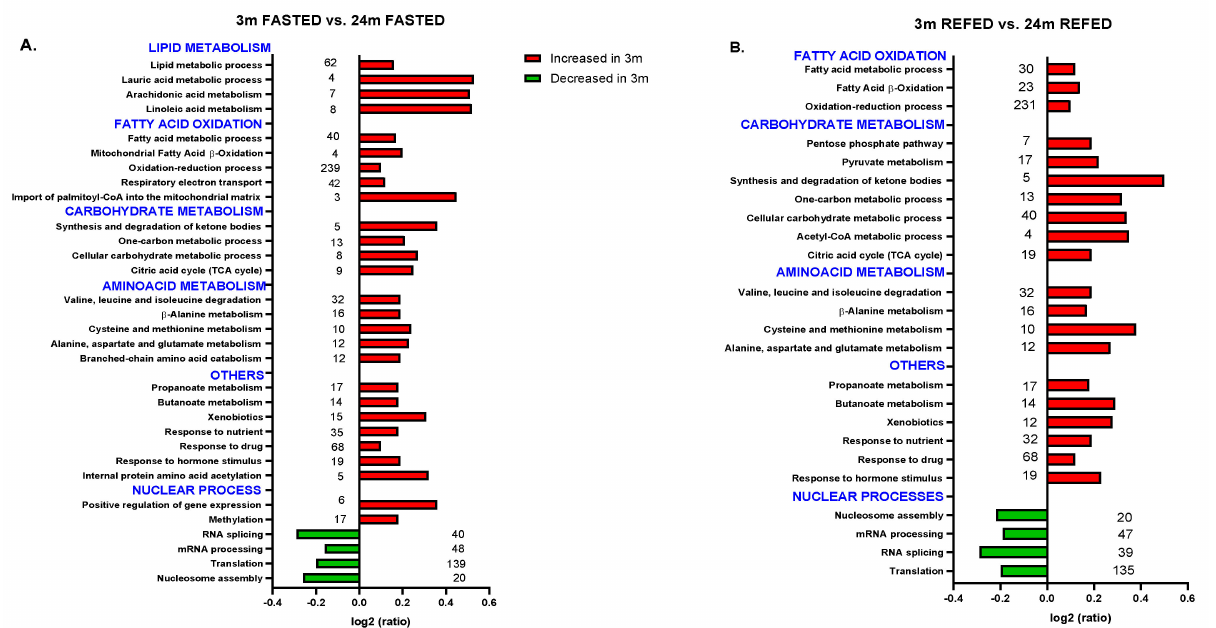
Figure 2. Biological processes and metabolic pathways affected in hepatic NEF of fasted or fasted/refeed rats with aging. Data showed changes in 3- compared with 24-month-old animals. ( A ) Changes after 36 h fasting. ( B ) Changes after 36 h fasting and then refeeding for 30 min. The most representative GOBP and KEGG categories are shown indicating the number of identified proteins per categories. Data are presented as protein log2-ratios between the different experimental groups according to their estimated variances (z q values, see Supplementary Table S4). Red colors represent processes higher in 3- than in 24-month-old rats. Green colors represent processes lower in 3- than in 24-month-old